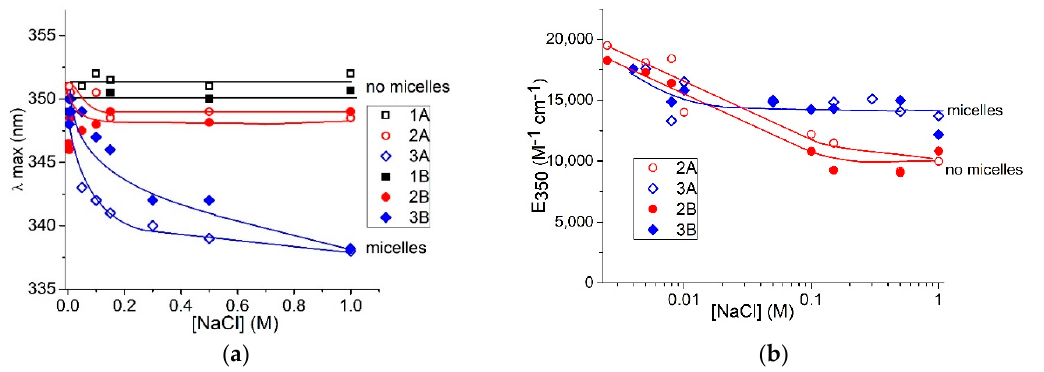
Figure 6. Dependence of hypsochromic shift ( a ) and hypochromic effect ( b ) on [NaCl] for free surfactant (A) and surfactant in complexes with DNA at z = 0.5 (B). [AzoTAB] = 2 × 10 − 6 M (1); 4 × 10 − 6 M (2); 1.8 × 10 − 4 M (3).